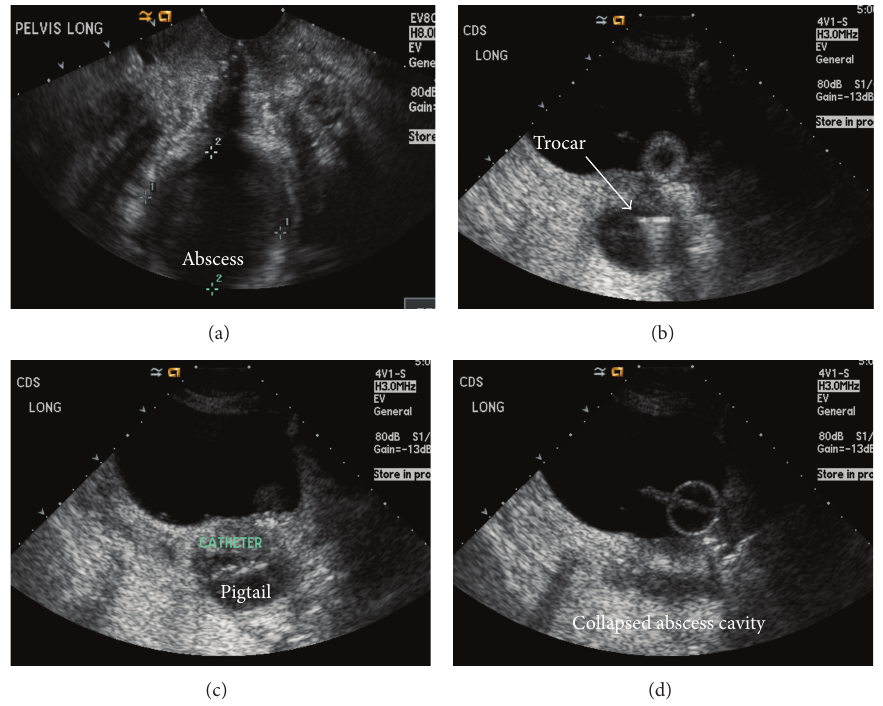
Figure 1: (a) Transvaginal ultrasound shows a small collection in the rectouterine space. (b) Sagittal transabdominal ultrasound shows the trocar puncturing inferiorly through the vaginal cuff. (c) 6 F pigtail catheter is advanced into the collection. 45 mL of pus was aspirated with collapse of the abscess cavity (d). The catheter was removed 2 days later and the patient was discharged. Cultures were